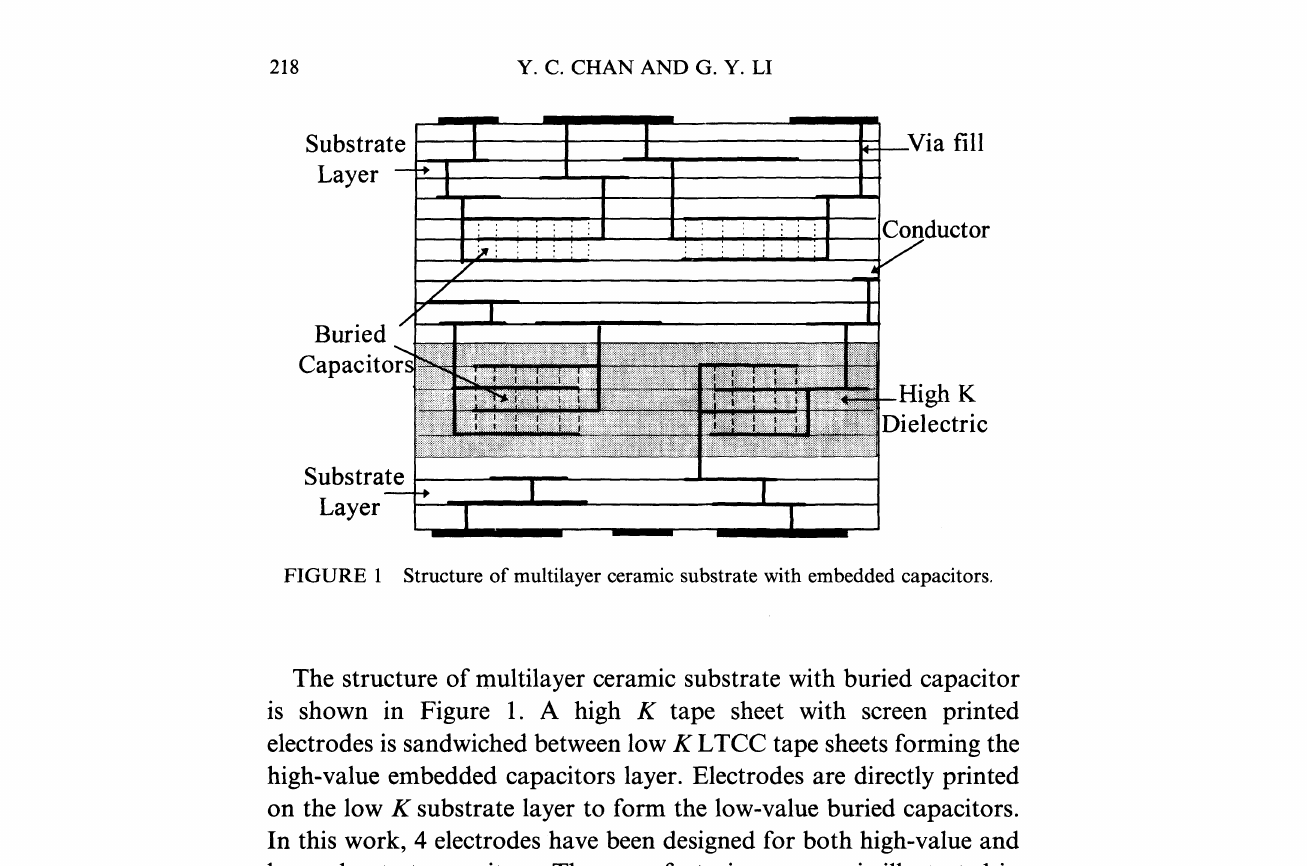
FIGURE Structure of multilayer ceramic substrate with embedded